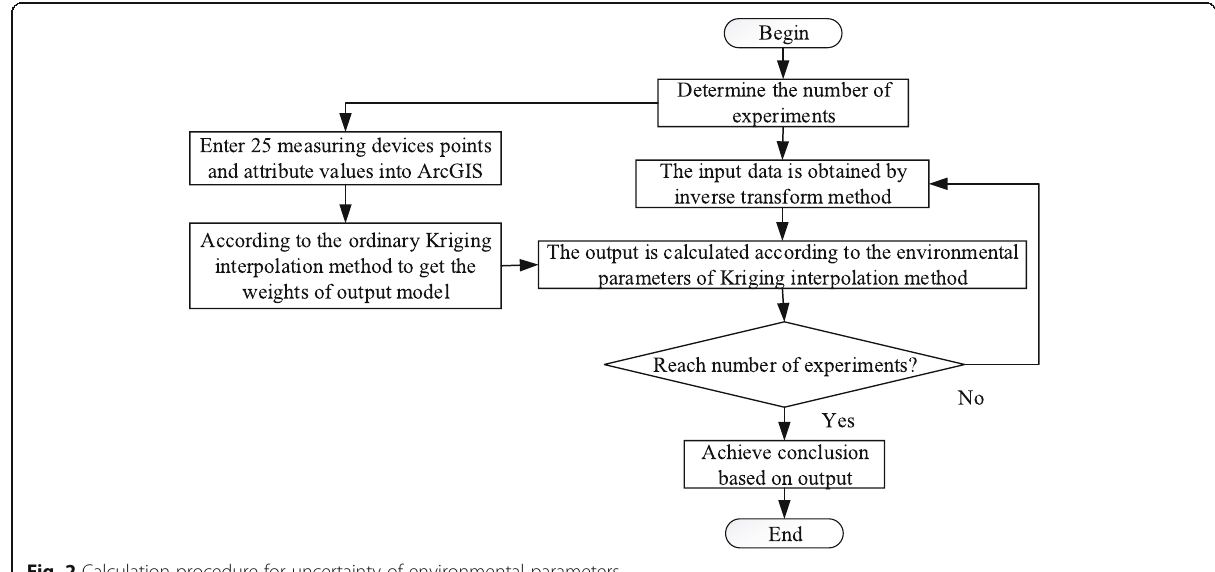
Fig. 2 Calculation procedure for uncertainty of environmental parameters